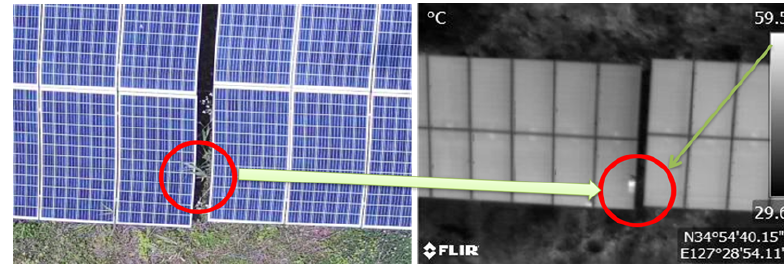
Figure 12. Hotspots caused by weed shadows: 59.5 °C.